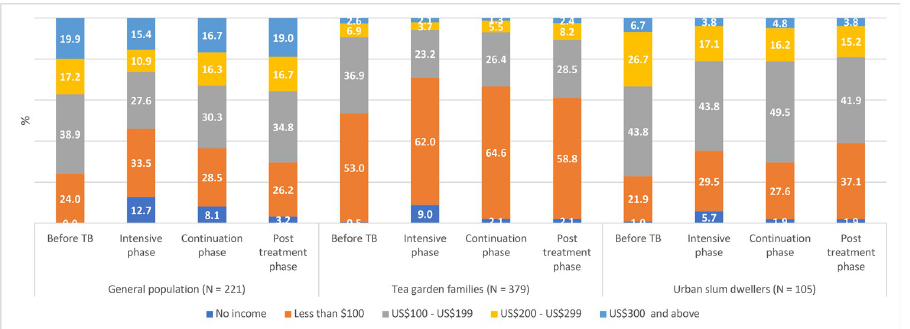
Fig 2. Income status of the households of sampled TB patients at different phases.